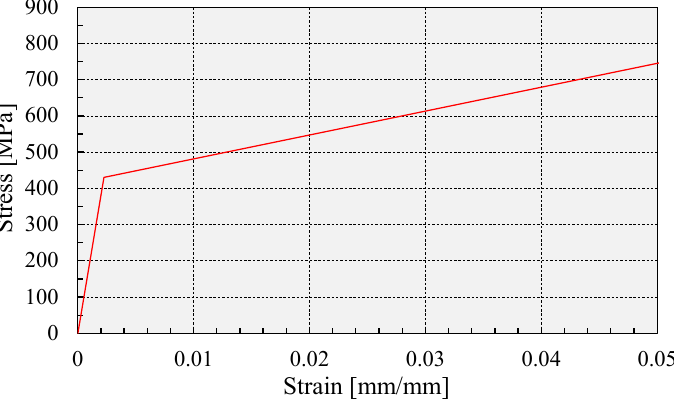
Figure 11. A material model of the steel material C45 for the semi-analytical solution. Table 2. Semi-analytical vs. experimental results for vertical components.